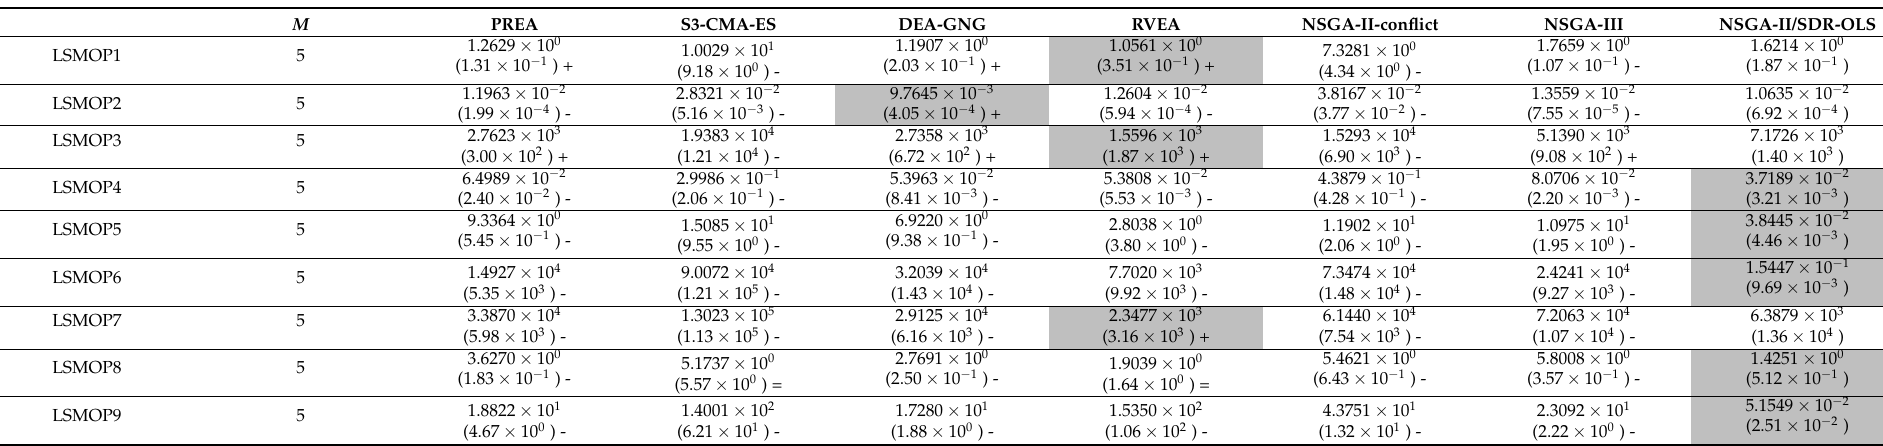
The gray background represents that this algorithm has the best performance on this problem. The number in the brackets represents the standard deviation, and the number out of the brackets represents the mean values. “+/-/=” means that the relevant algorithm performs better than/worse than/as well as the NSGA-II/SDR-OLS algorithm. Same below table. Table 9. GD values for 9 five-objective benchmark